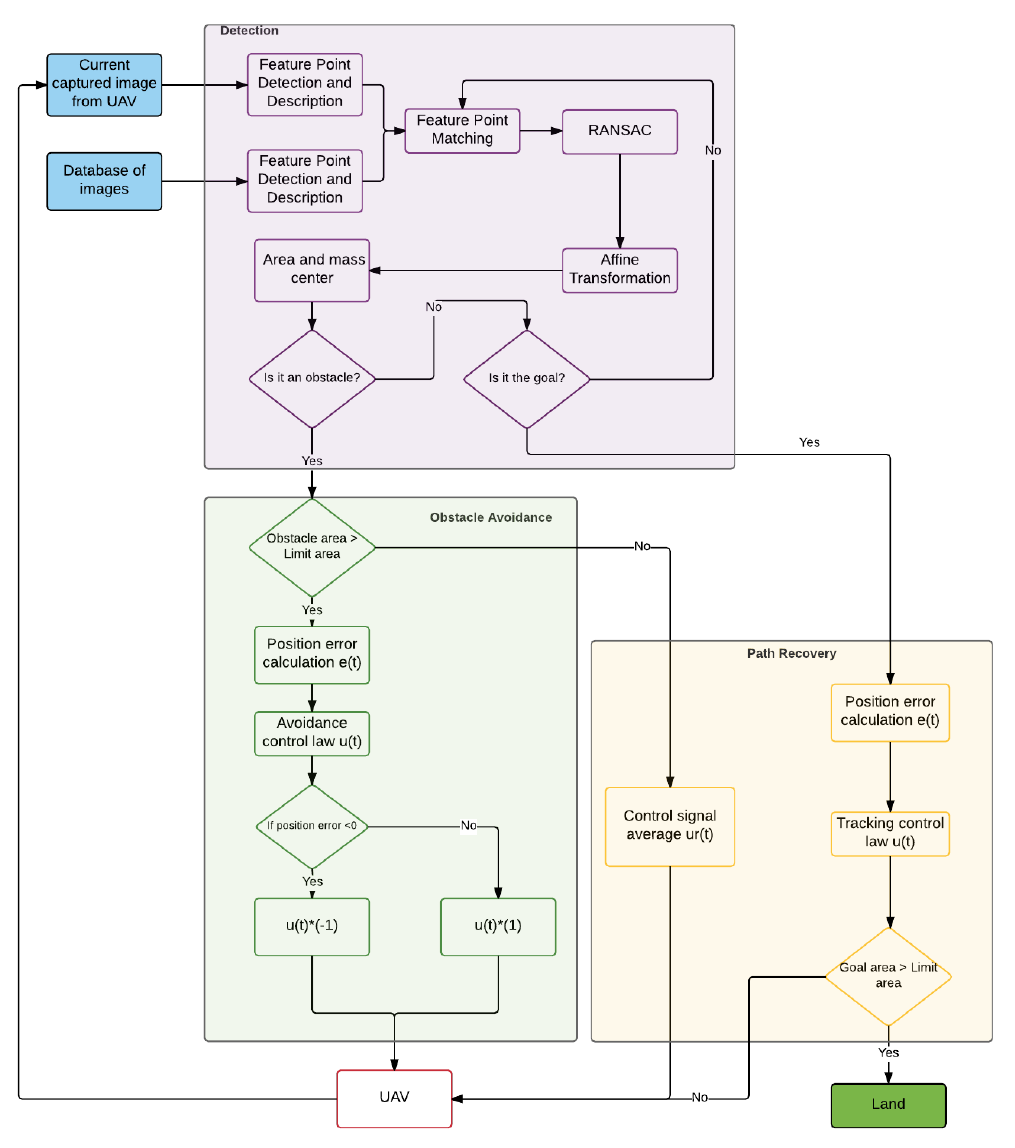
Figure 15. Flow chart. Our proposal for obstacle